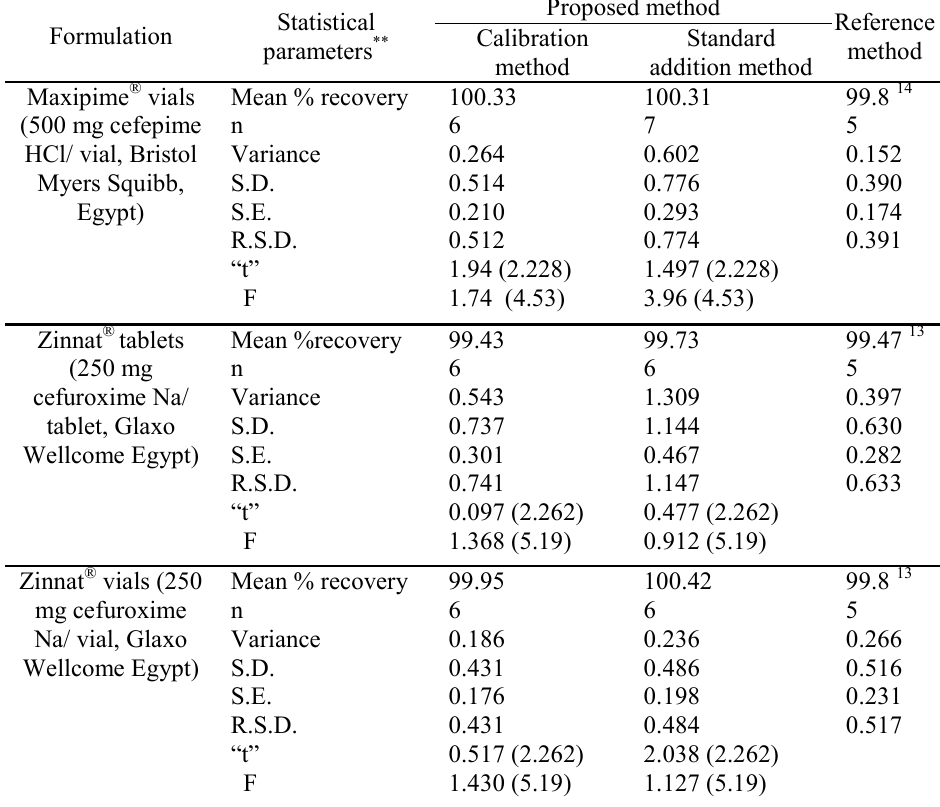
Table 4. Comparative analytical results of the proposed and the reported methods for tested drug in some pharmaceutical formulations: